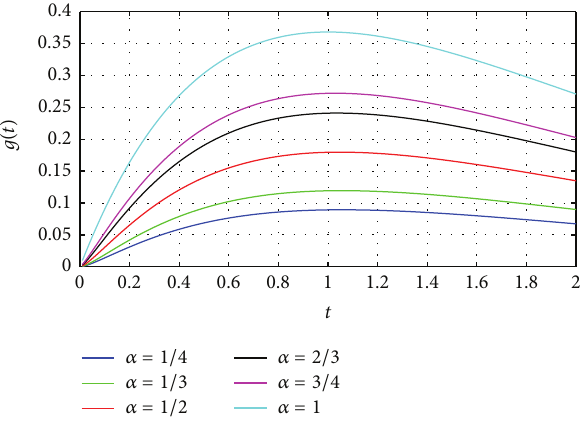
Figure 1: Curves of function 𝑔(𝑡) = 𝑡/𝑒 𝑡 𝛼 ( 𝑡 > 0 ) with different 𝛼